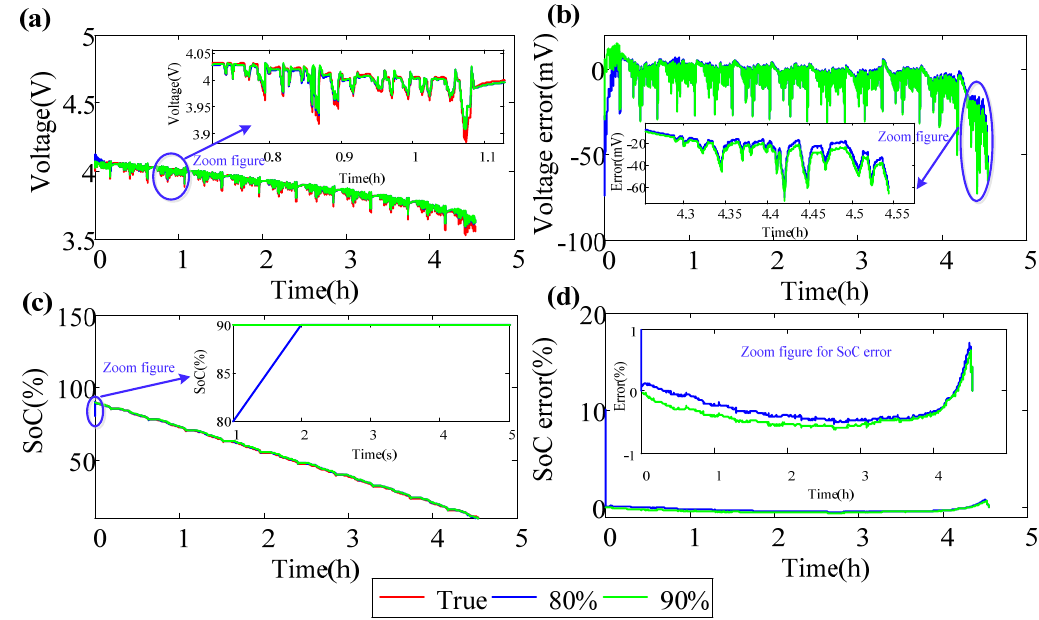
Figure 17. SoC estimation results with different initial SoCs of the LiMn 2 O 4 cell: ( a ) Voltage; ( b ) Voltage error; ( c ) SoC; ( d ) SoC